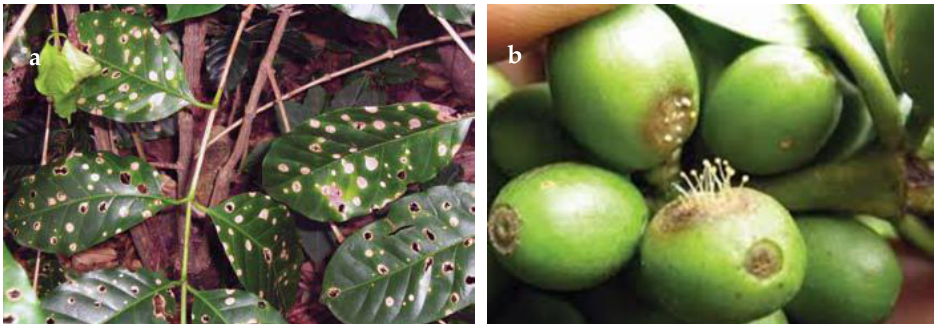
Figure 2. Attack of American Coffee Spot, by Mycena citricolor. ( a ) on coffee leaves, leading to total degradation of attacked areas, forming conspicuous holes in the leaves. ( b ) Minute fruiting bodies (caps) of M. citricolor invading coffee berries. The berry is strongly affected by the fungal infection, causing brown necrotic tissue. The entire infected area is sunken in, flattening the shape of the infected coffee fruit. In short, the figure hints the effect of a plant pathogen with a powerful, pectinolytic as well as ligninolytic secretome of biomass degrading enzymes. Photos: Andrew